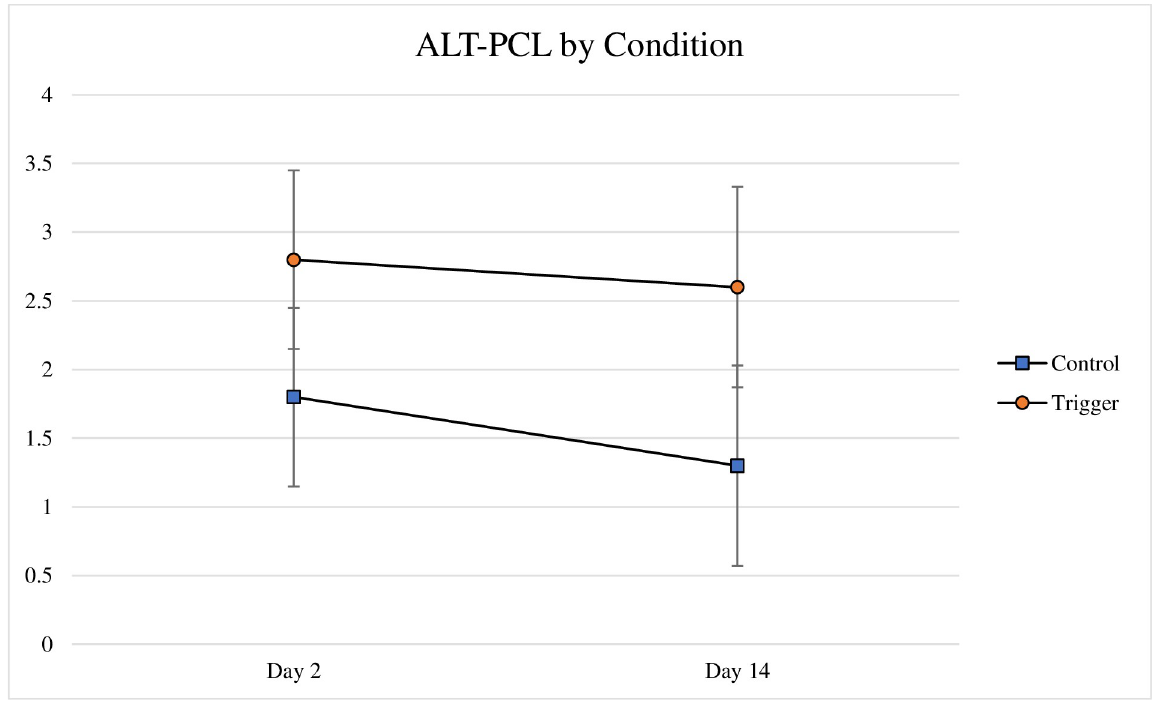
Fig 2. Alt.PCL by trauma and time. Average alternative PTSD checklist scores shown with standard error bars as a function of the control (n = 32) and triggering conditions (n = 218).